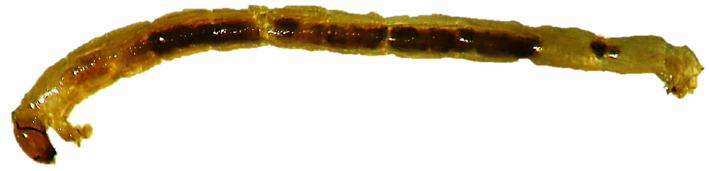
Figure 12. Example of chironomid that can be used for ecotoxicity assessment.